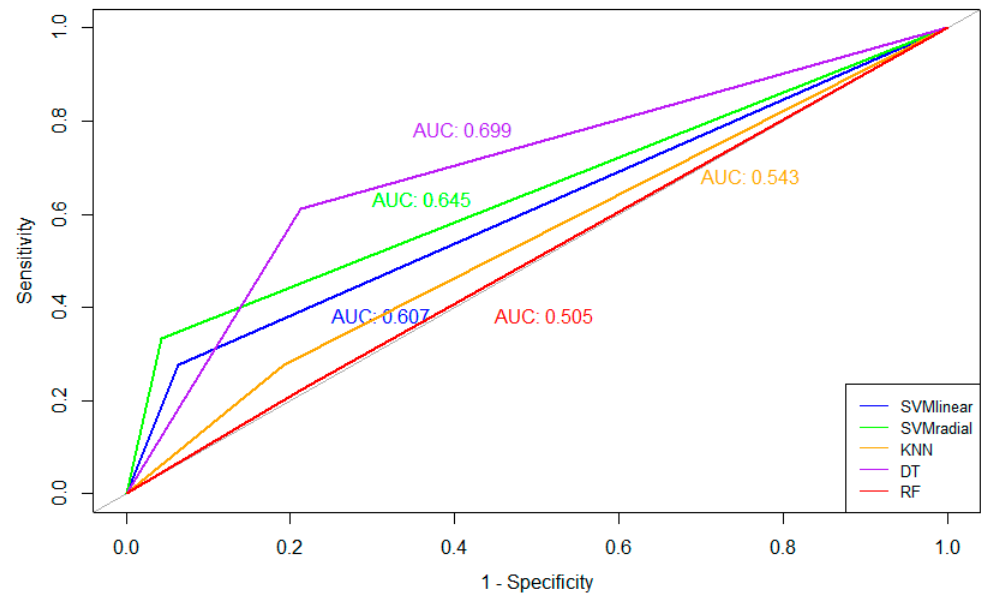
Figure 3. Receiver Operating Curves (ROC) curves of the five models. The performance of the sup-